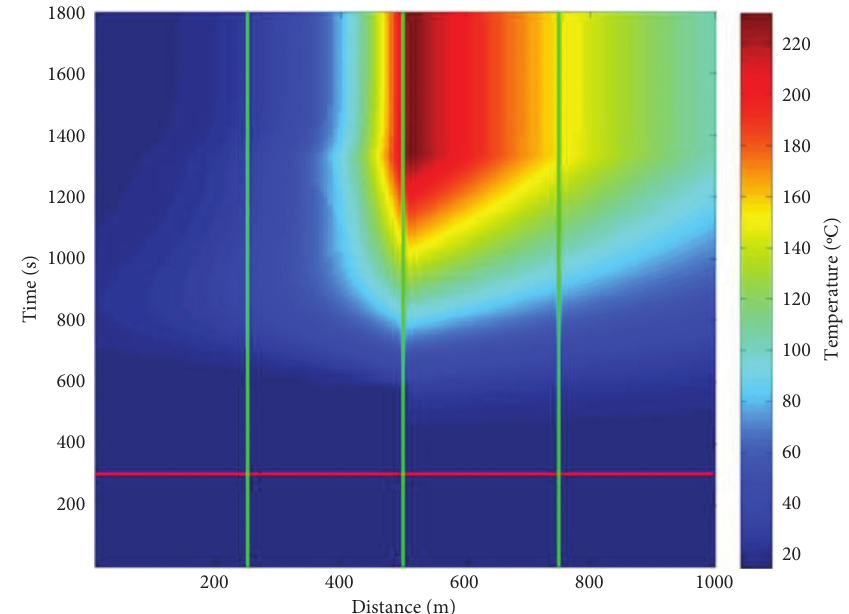
Figure 17: Development of temperature over space and